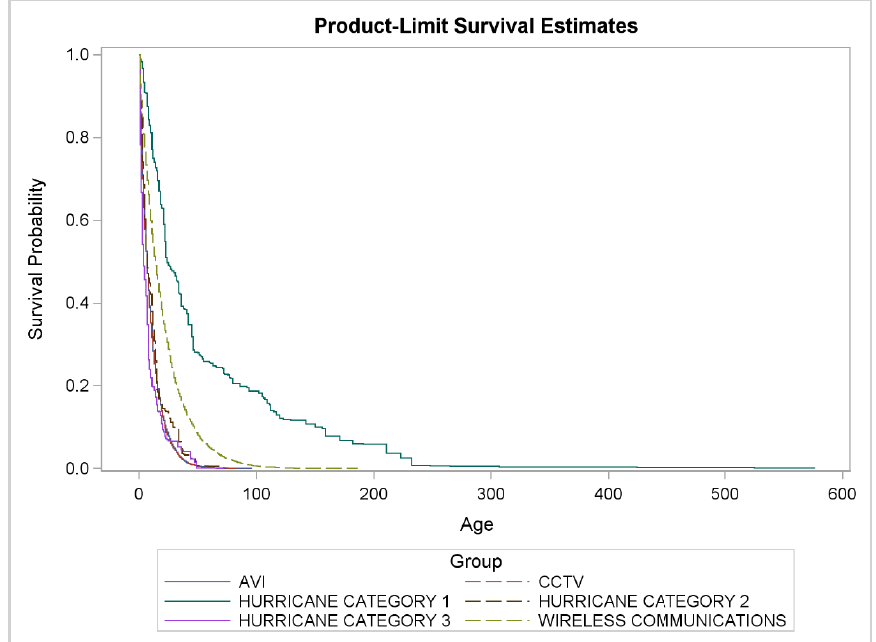
Figure 8. Product limit survival estimates for vehicle tracking and detection systems (CCTV, AVI and WIRELESS COMMUNICATIONS) compared with hurricane failure intensities. Table 3. Maximum likelihood estimates (DMS components).